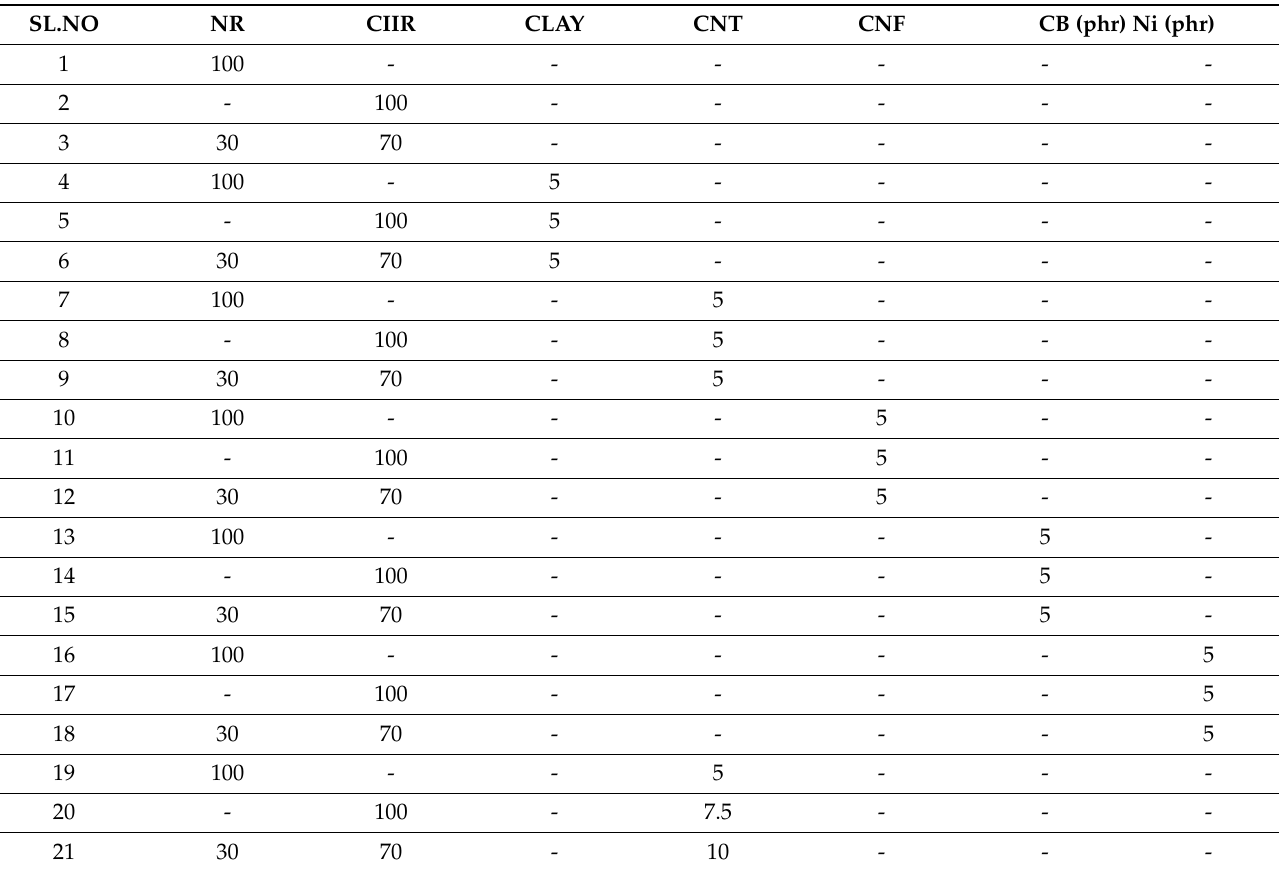
Table 1. Composition of rubber nanocomposite with different nanofillers to fillers.